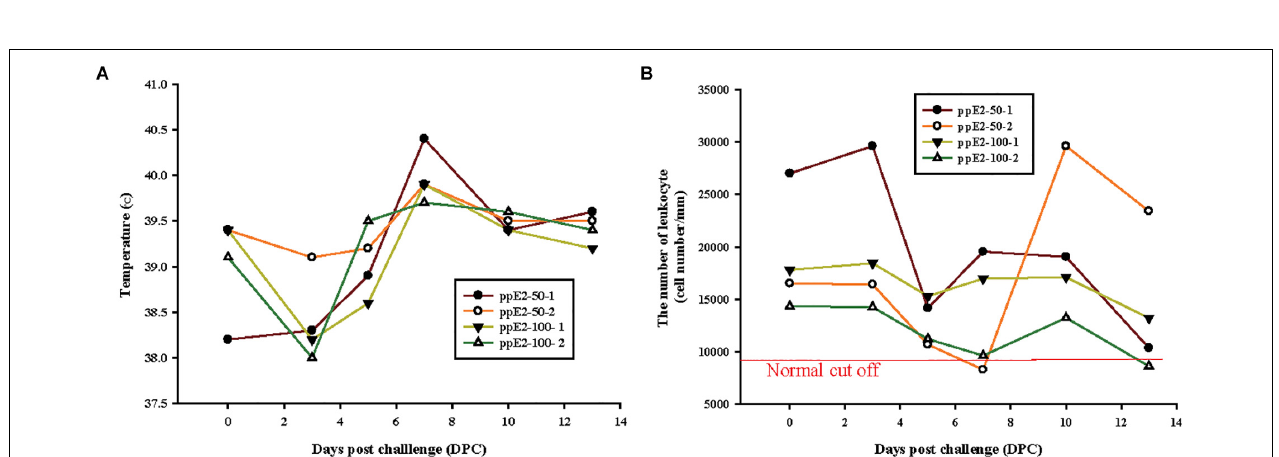
FIGURE 6 | Plant-produced E2 fusion protein vaccination provides protection from classical swine fever virus challenge. (A,B) Two piglets were immunized with two doses of either 50 µ g or 100 µ g of plant-produced E2 fusion protein (ppE2), and challenged with virulent classical swine fever virus (CSFV). Symptoms of CSFV infection in vaccinated animals are shown. Body temperature (A) and total leukocyte counts (B) were examined at 0, 3, 5, 7, 10, and 13 days after viral challenge. The individual data points were presented.